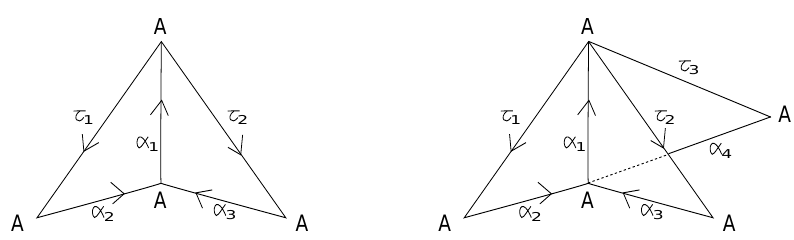
Figure 3 . 2-cell for S n TFT2 interpretation of correlator at d = 3 (left) and d = 4 (right). The 2-cells in the 2-complexes are ( (cid:11) 1 (cid:28) l (cid:11) l ), l = 2 ; 3 ; 4.